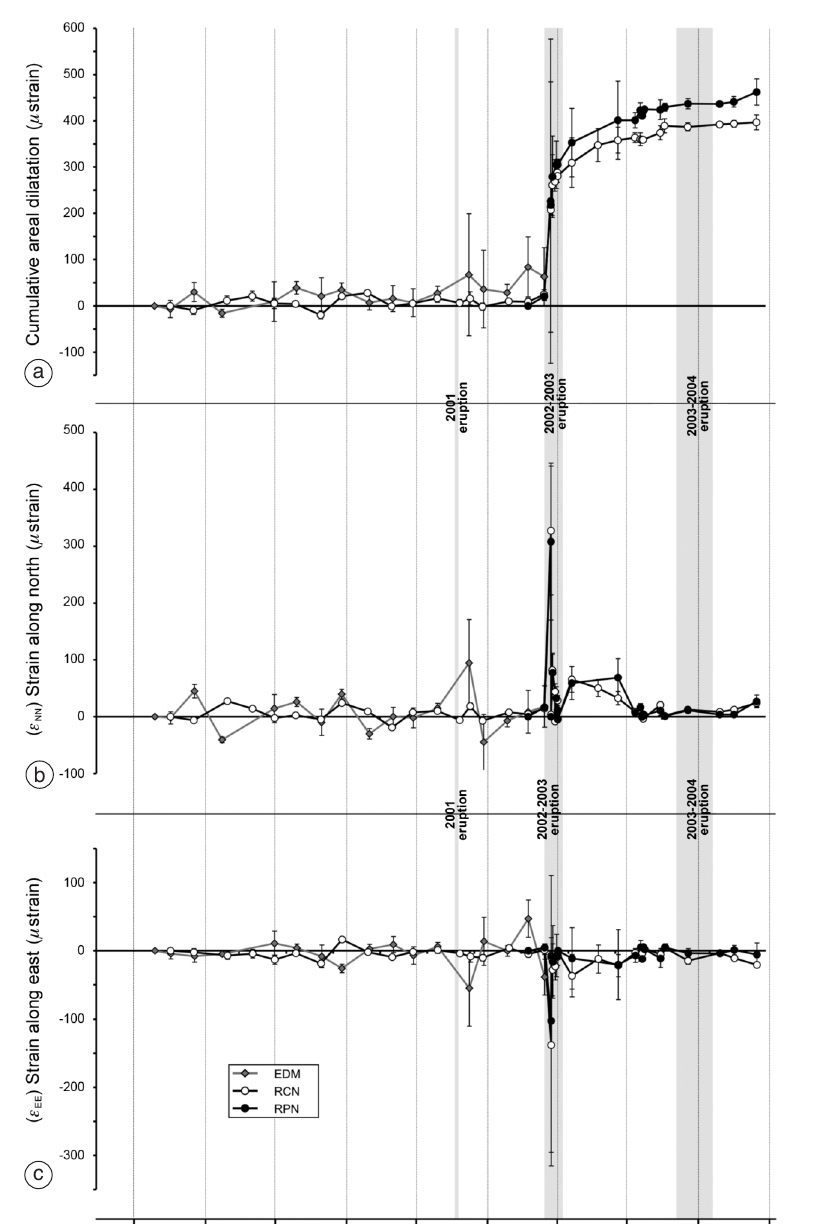
Fig. 8a-c. Time evolution of strain patterns at the geodetic networks: a) cumulative areal dilatation; b) north- south component of the strain tensor; c) east-west component of the strain tensor. Strain is assumed to be posi- tive for dilatation and for